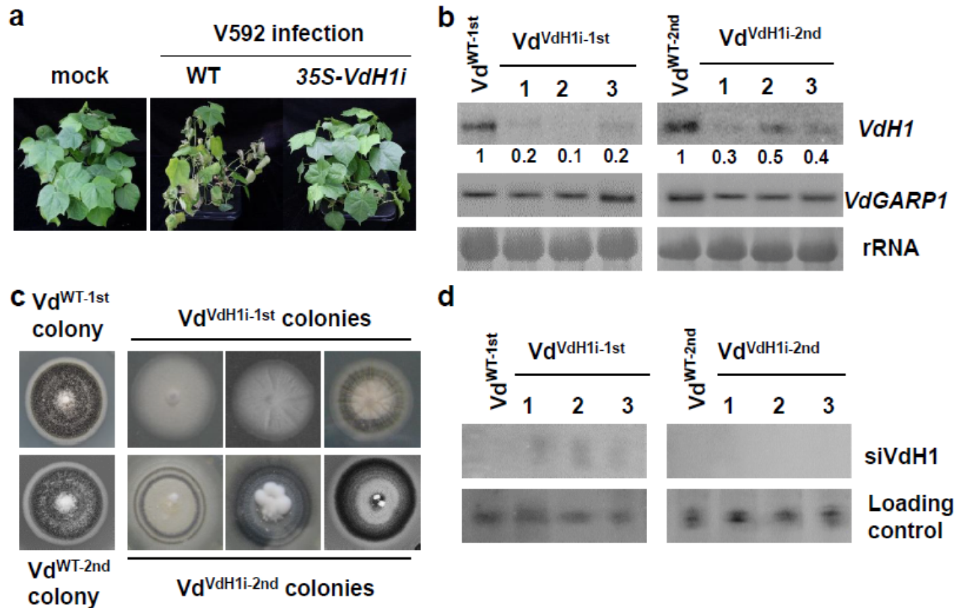
Figure 2. Examination of VdH1 mRNA and siVdH1 in hyphae recovered from infected cotton. ( a ) Dis- ease symptoms of V592 infection on wild-type and transgenic cotton plants. ( b ) Detection of VdH1 mRNA in colonies recovered from wild-type and 35S-VdH1i transgenic cotton plants. The numbers below represent relative signal intensities. Hyphae grown from stems at 5 days post-culture were transferred to PDA medium to continue growth, named Vd VdH1 − 1st colonies. Subculture colonies propagated from hyphae of Vd VdH1 − 1st colonies were named Vd VdH1 − 2nd colonies. ( c ) Morphologies of Vd VdH1 − 1st colonies and Vd VdH1 − 2nd colonies. Photographs were taken 20 days post-culture. ( d ) Small RNA hybridization of siVdH1 in Vd VdH1i − 1st colonies and Vd VdH1i − 2nd